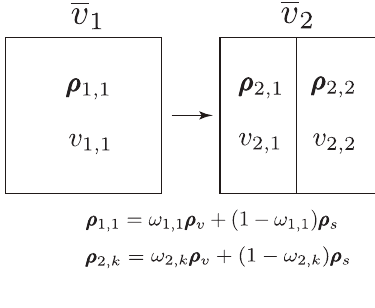
indicates the area-averaged NDVI j and (cid:26)(cid:26)(cid:26) with weights ! . v s j,k